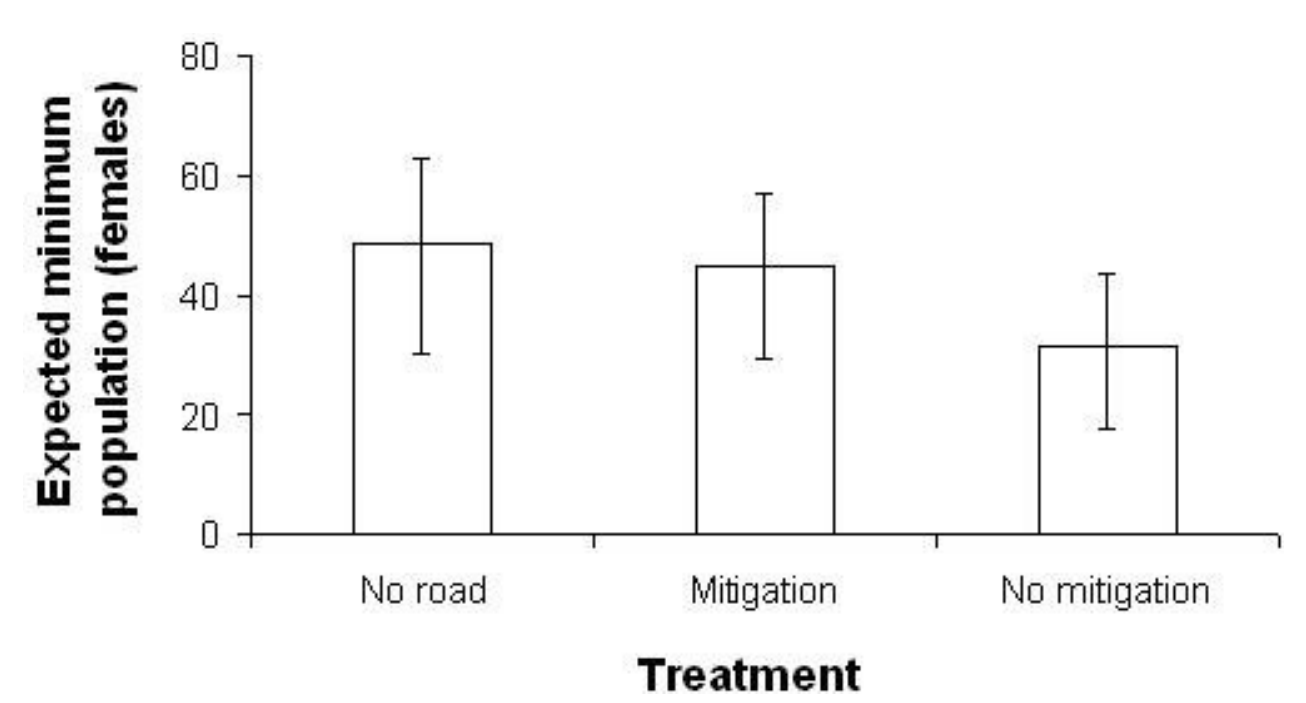
Fig. 2. Expected minimum female population size of B. parvus at Mount Higginbotham, 20 years after construction of tunnels and boulder corridor to mitigate the barrier effect of a road and adjacent habitat degradation. The error bars are 95% credible intervals that propagate the uncertainties in parameter